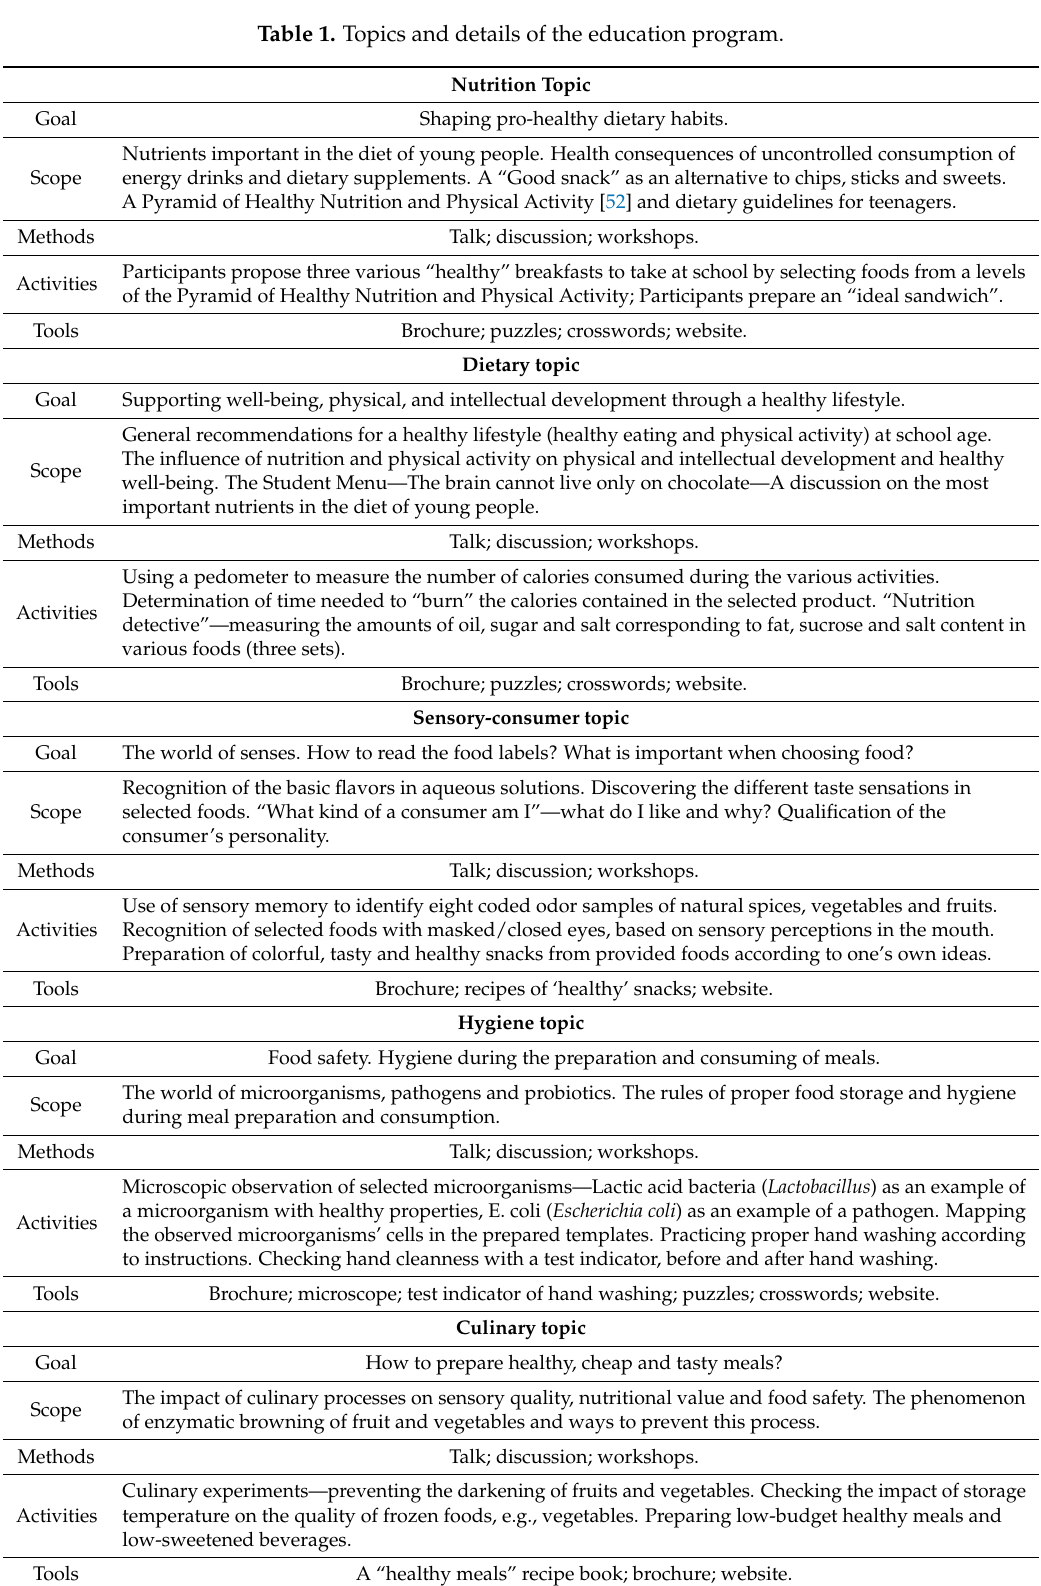
Table 1. Topics and details of the education